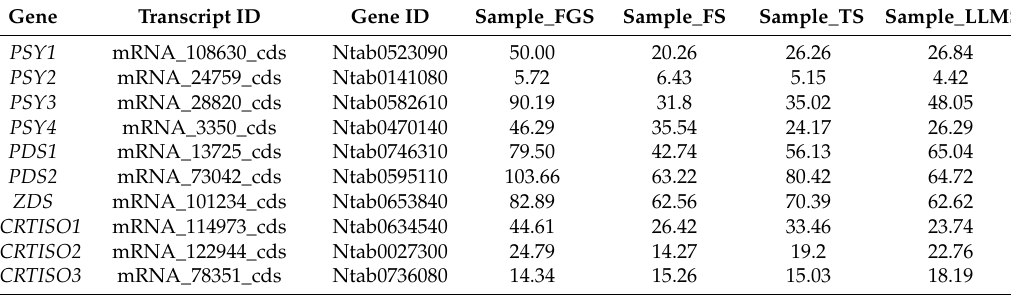
Table 1. Transcript levels of genes in the carotenoid biosynthetic pathway based on RNA sequencing analysis of samples from leaves of four different growth stages in tobacco, including the fast growing stage (FGS), the flowering stage (FS), the topping stage (TS), and the lower leaf maturity stage (LLMS). The full-length and coding sequences of gene in the carotenoid biosynthetic pathway are listed in Supplementary File